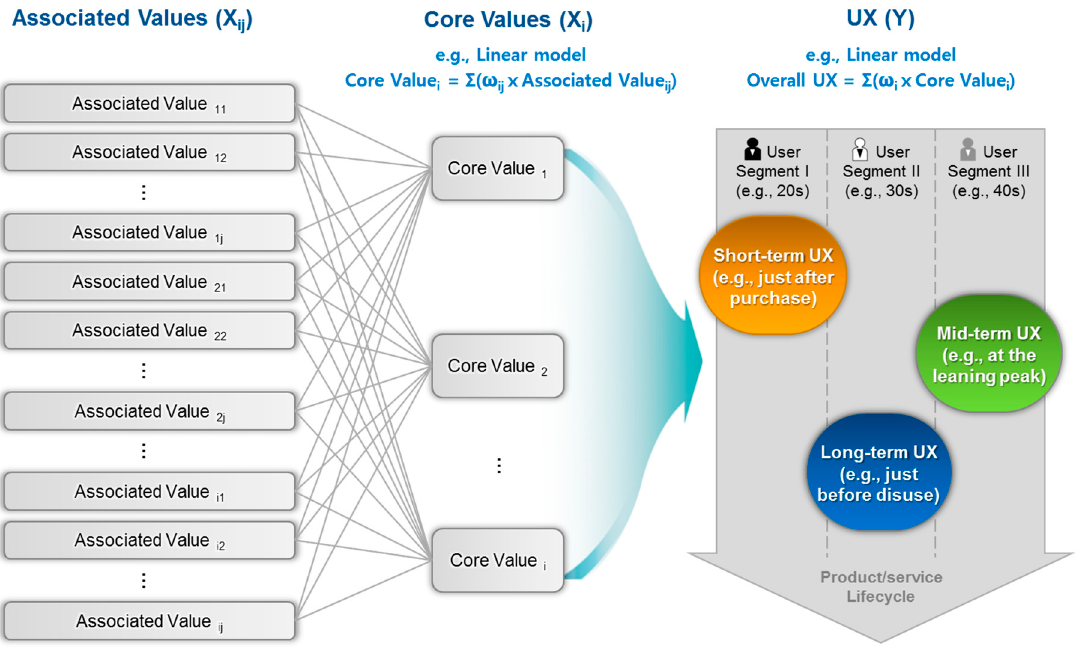
Figure 1. User experience (UX) quantification model with value structure.